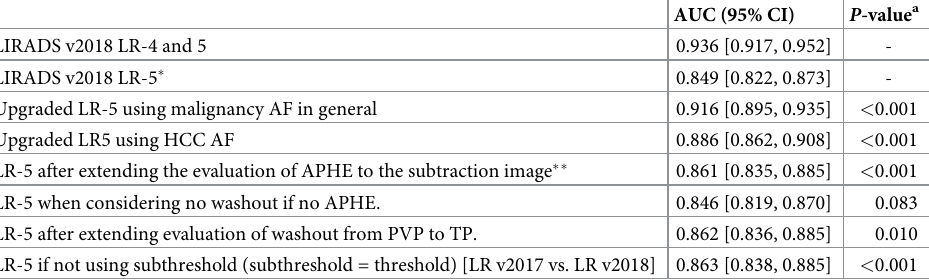
Table 3. Area under the curve (AUC) of various